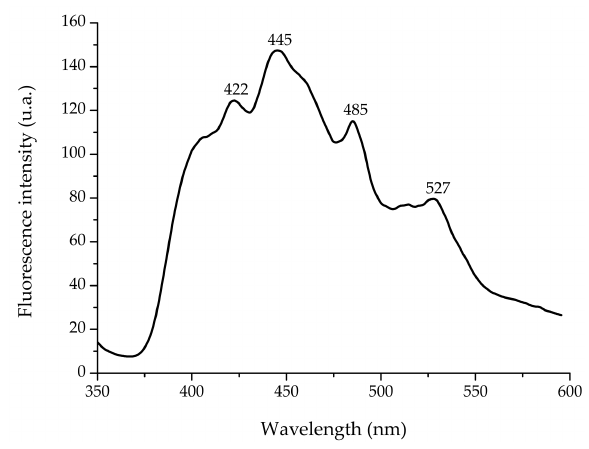
Figure 2. ( a ) Diffuse reflectance spectra, and ( b ) Kubelka–Munk transformed reflectance spectra of synthesized ZnO nanoparticles.